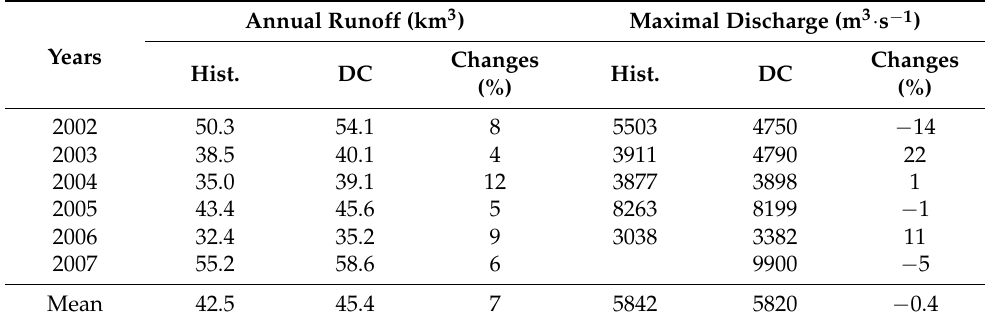
Table 4. Simulated runoff characteristics under historical data series (Hist.) and DC scenario (DC) for the 2002–2007